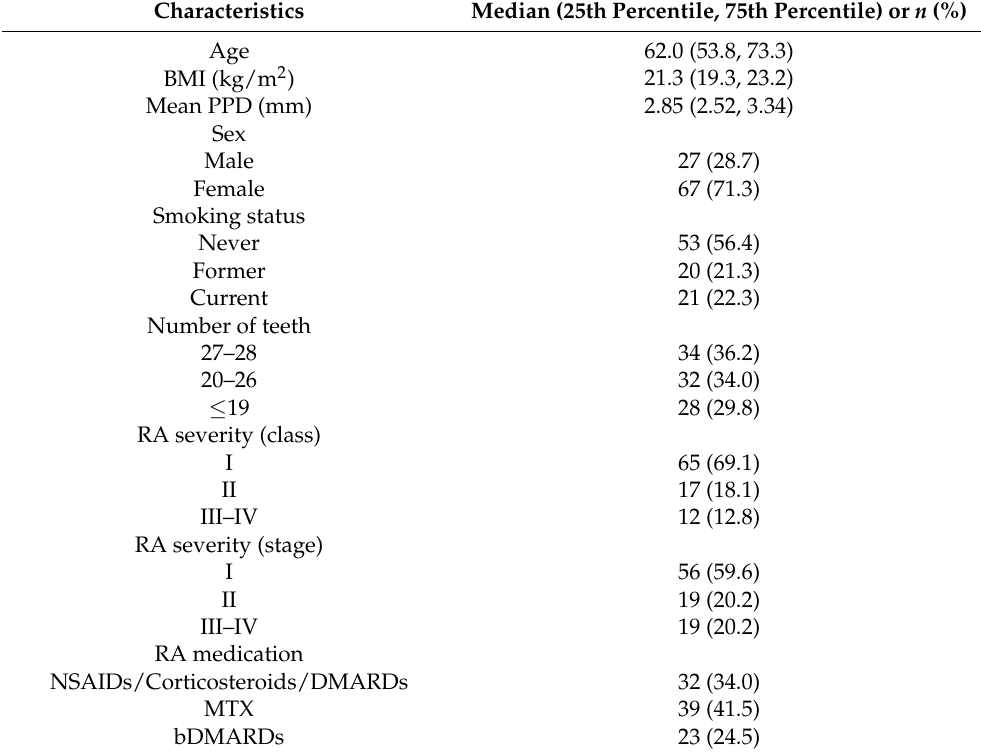
Table 1. Characteristics of study patients.